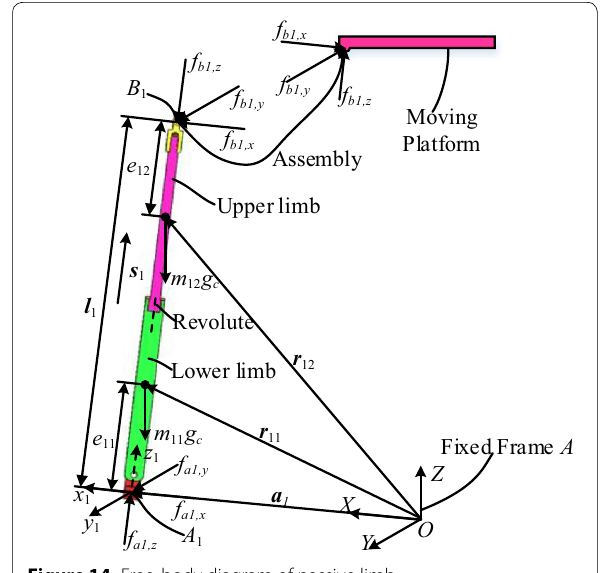
Figure 14 Free-body diagram of passive